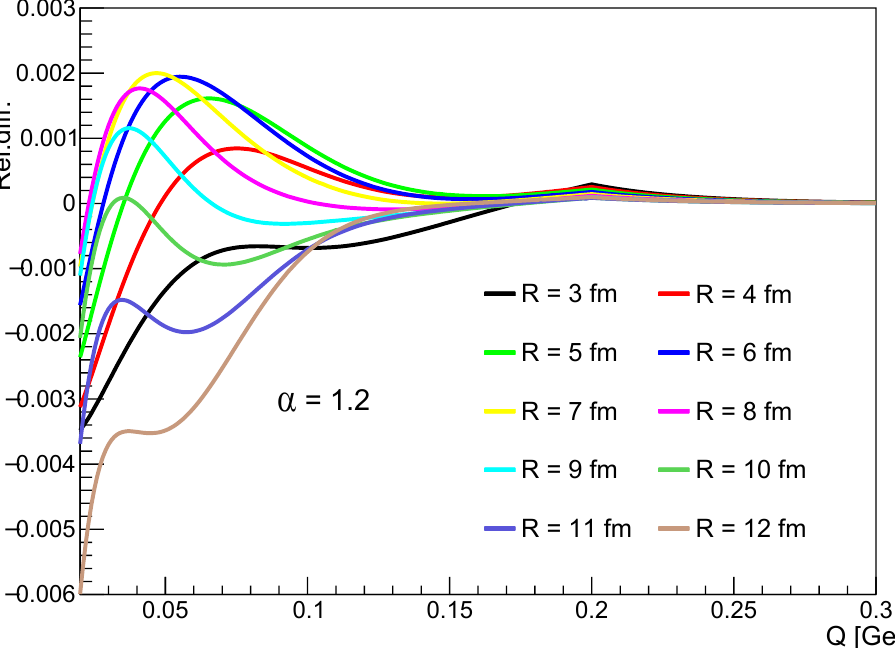
Figure 4. The relative deviation of the parametrization measured in % form the table for a given α with various R values within the domain of the